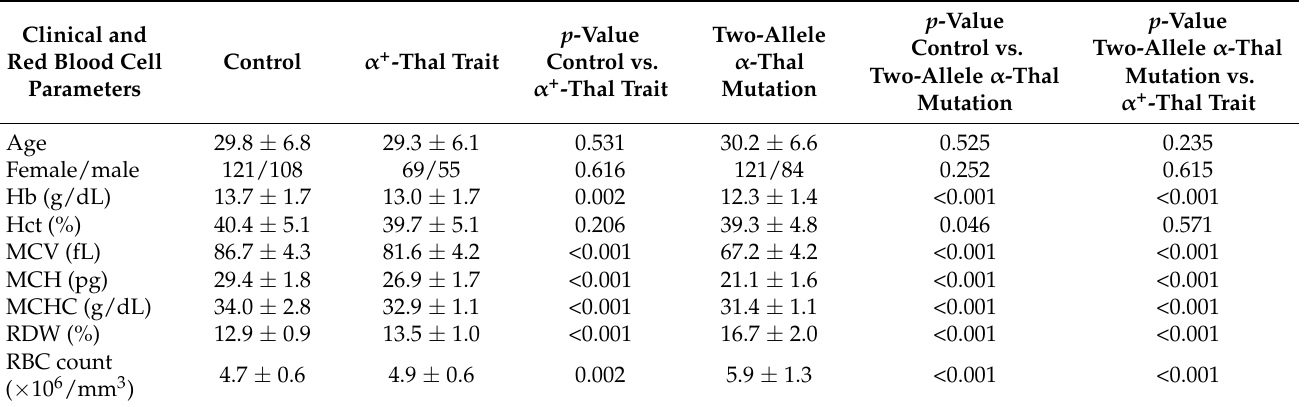
Table 2. Comparisons of clinical and red blood cell parameters between the α + -thalassemia trait ( α + -thal trait) vs. normal controls (not thalassemia), two-allele α -thal mutation vs. normal controls, and α + -thal trait vs. two-allele α -thal mutation